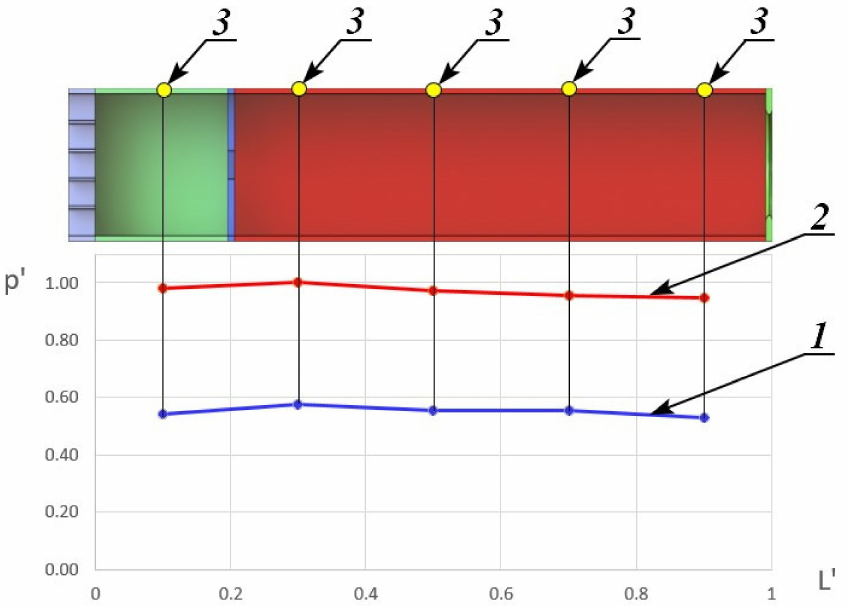
Figure 3. Dependence of the reduced pressure on the reduced length. 1—without combustion; 2—with combustion; 3—static pressure sampling point.